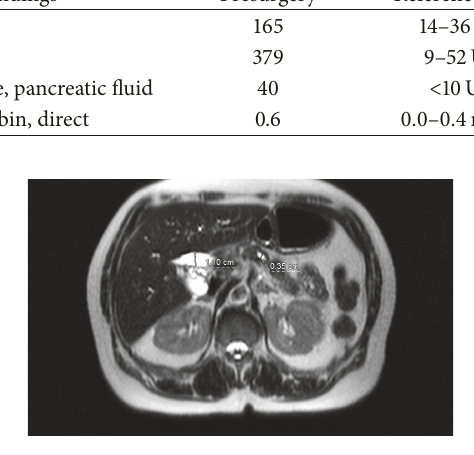
Figure 1: T2 axial CT: 10mm dilated common bile duct with distended gallbladder and 3.5 mm dilated pancreatic duct.